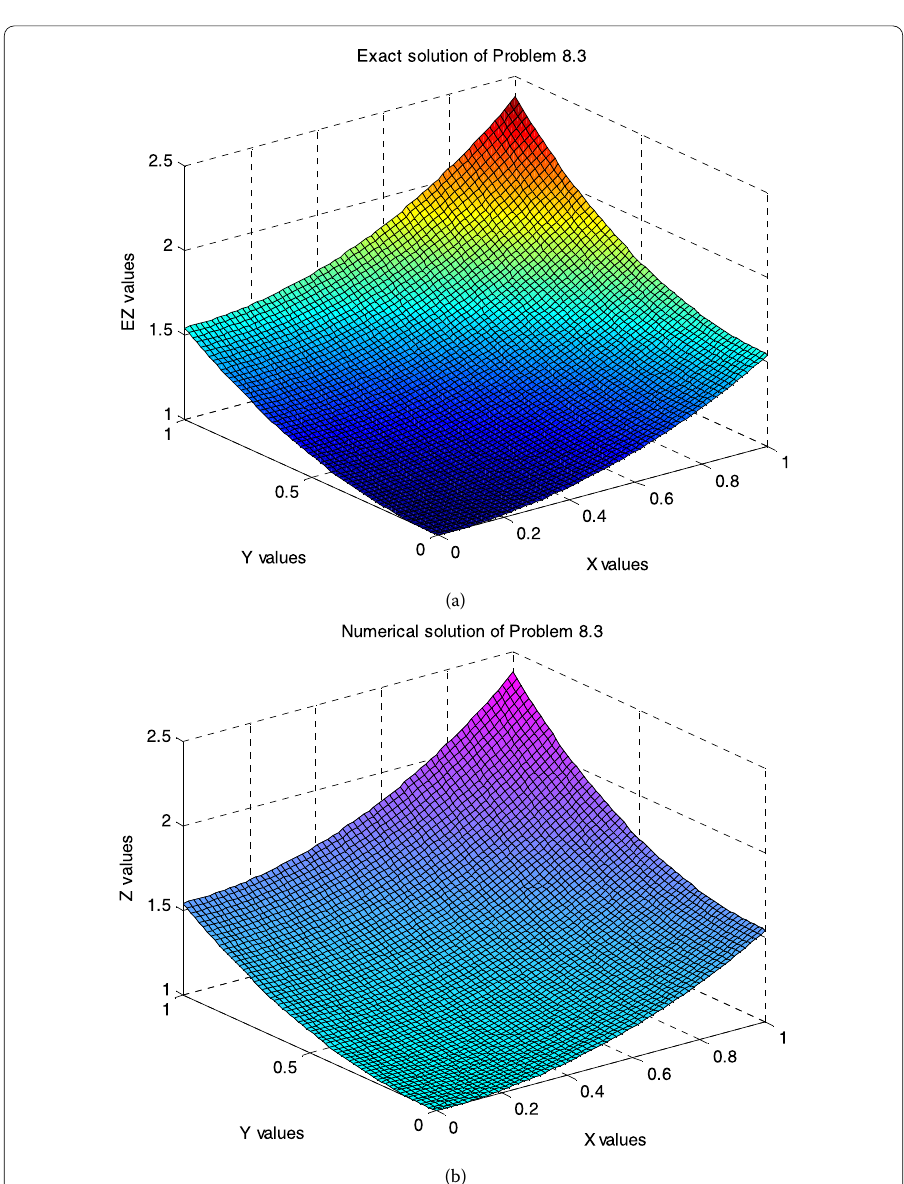
Figure 4 ( a ) Exact solution of Problem 8.3 for h = 1/64 and α = 2. ( b ) Numerical solution of Problem 8.3 for h = 1/64 and α =